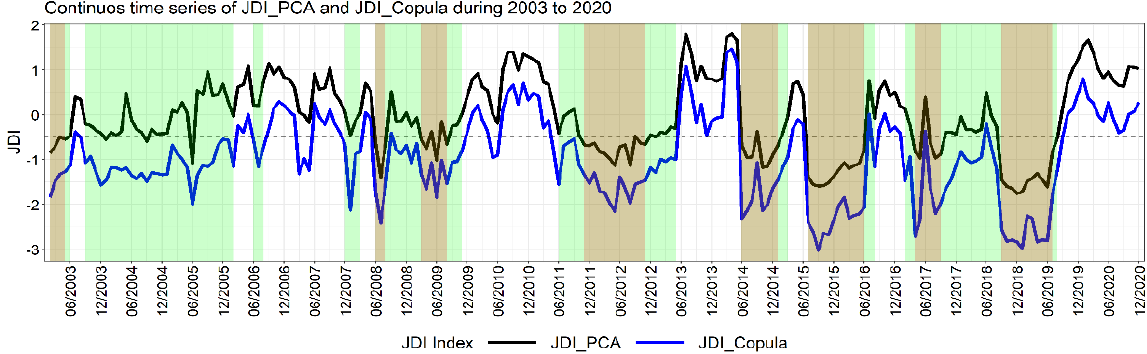
Figure 10. Continuous time series of JDI_PCA and JDI_Copula from 2003 to 2020 with scale 3_1_1_3 for June–September and scale 6_1_1_4 from October to May. Brown and green shaded regions represent drought periods for JDI_PCA and JDI_Copula, respectively. The dotted horizontal line represents JDI with intensity − 0.5.